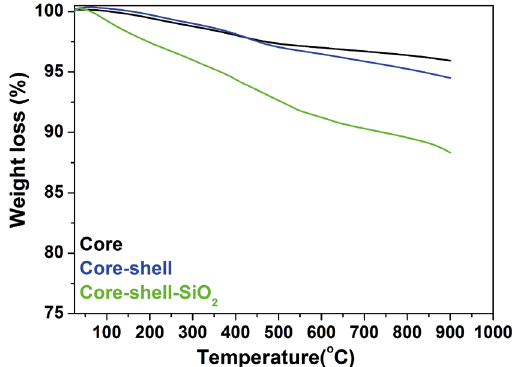
Figure 3. Thermogravimatric analysis of the core, core-shell and core-shell-SiO microspheres. 2